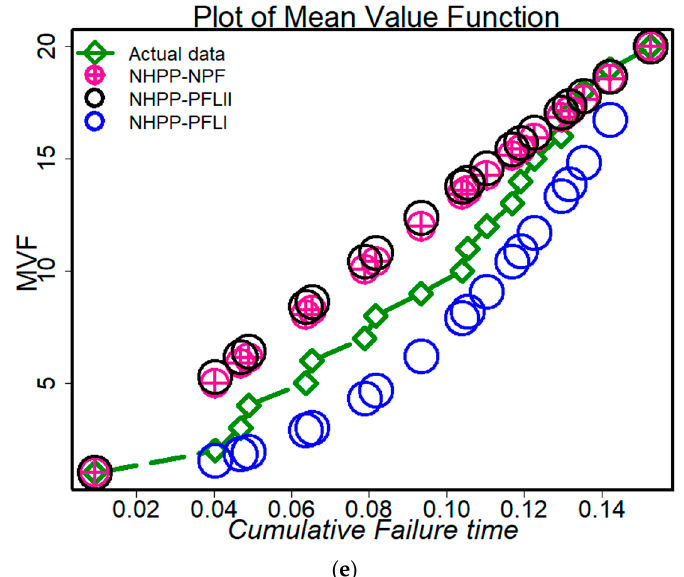
Figure 9. Observed and predicted results with five datasets: ( a ) DS1, ( b ) DS2, ( c ) DS3 ( d ) DS4, and ( e ) DS5.